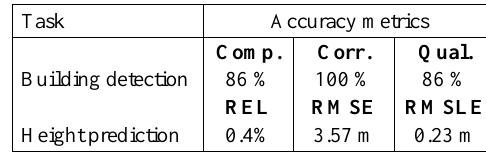
Table 1. The quantitative results of the proposed method